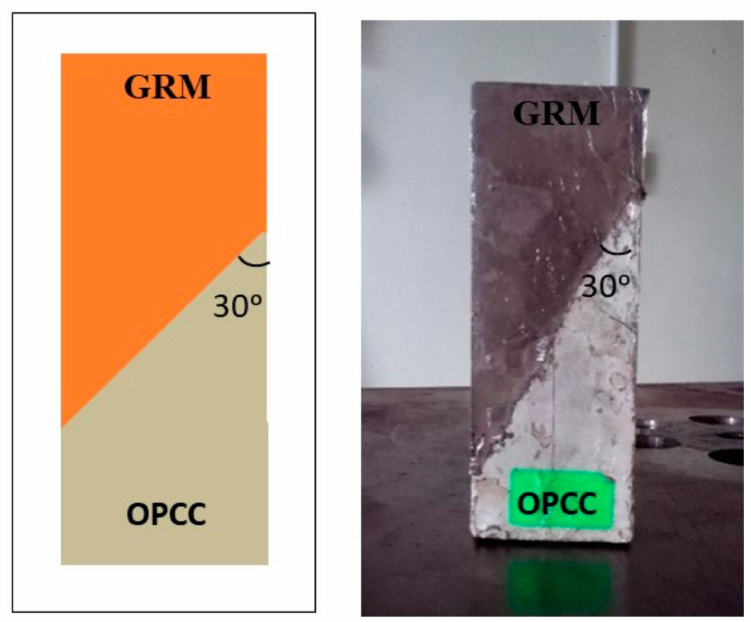
Figure 3. Schematic and experimental diagram of the composite specimen.